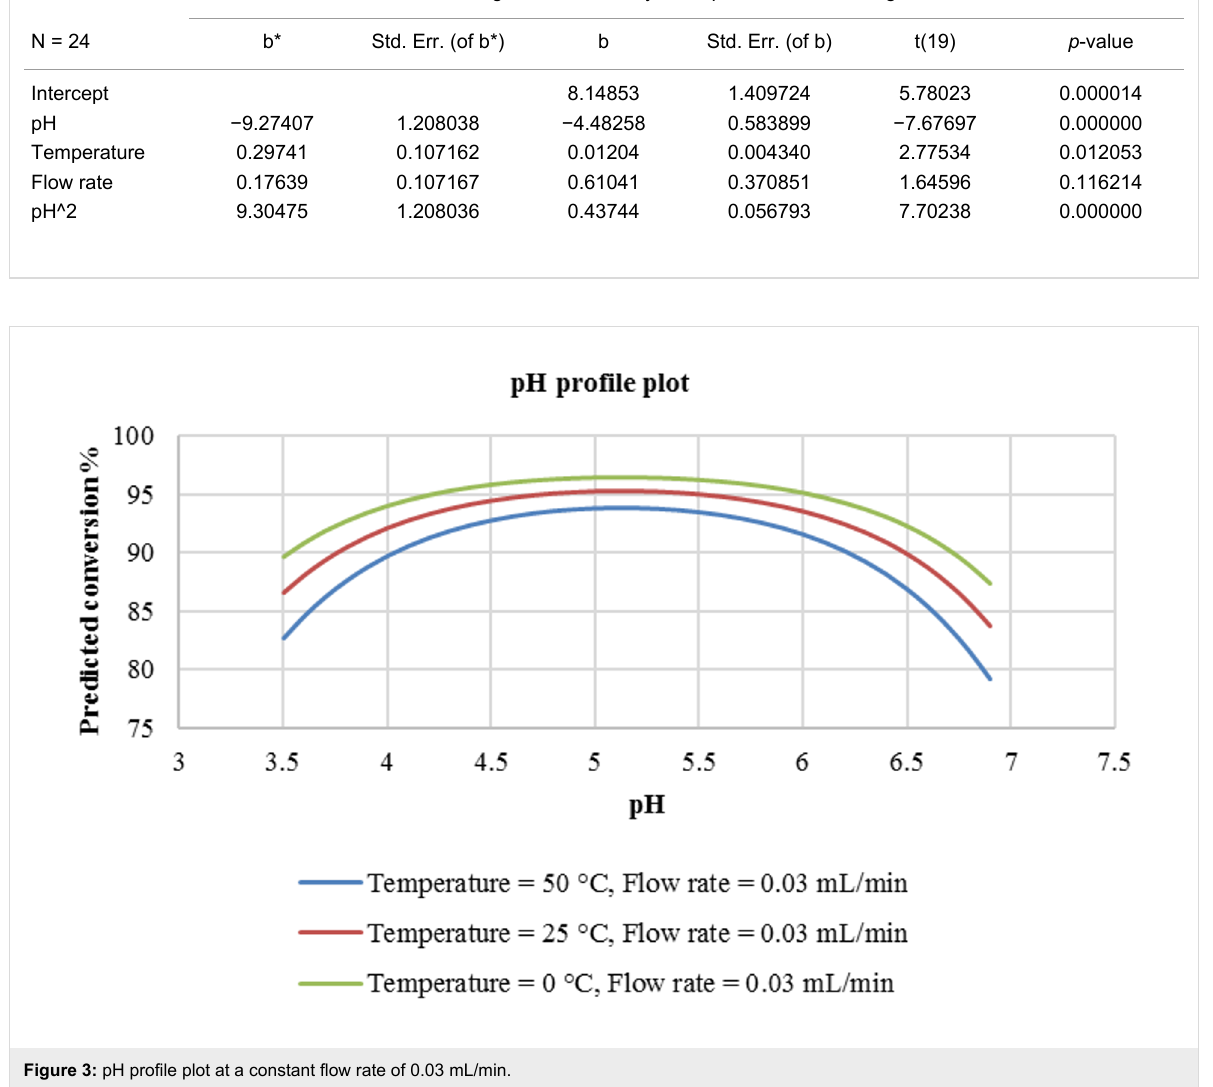
Table 4: Statistical multiple regression analysis output.